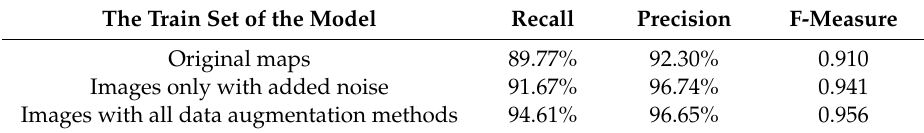
Table 2. Performance evaluation of the models trained by di ff erent train